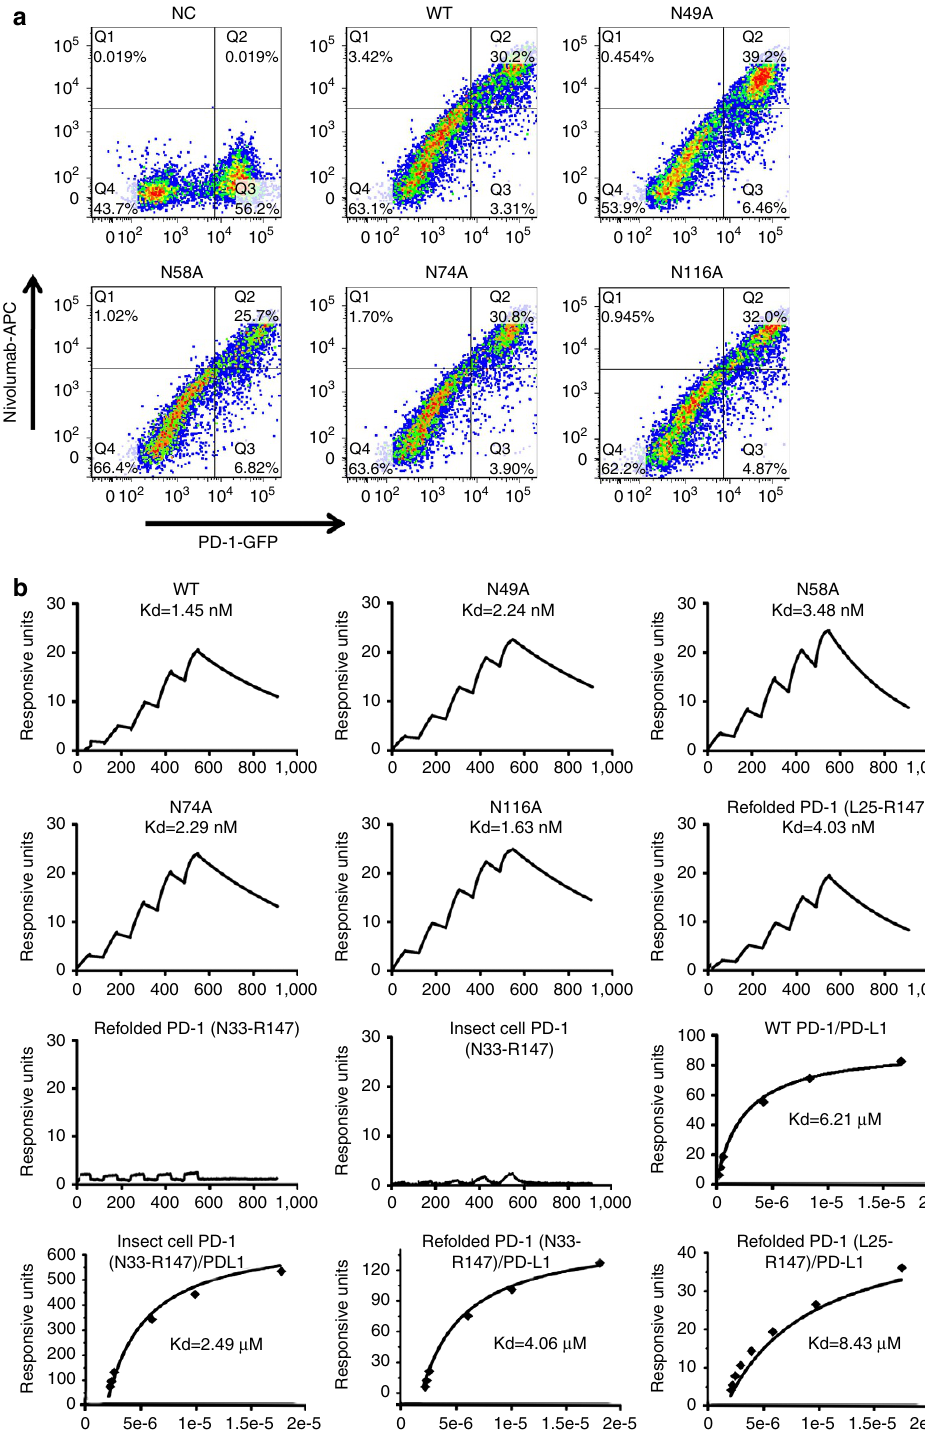
Figure 4 | No evidence for N-glycosylation involvement in nivolumab recognition. ( a ) A flow cytometric assay of nivolumab binding to PD-1 WT or various N-linked glycosylation sites mutated proteins (N49A, N58A, N74A and N116A) expressed on the cell surface of 293T cells. Plasmids expressing the full-length PD-1 WT or mutant proteins fused with EGFP at the C terminus were used for transfection. Mock-transfected 293T cells were used as negative control (NC). ( b ) SPR assay characterisation of the binding between nivolumab and various PD-1 mutant proteins using a BIAcoreT100 system. The PD-1 N-linked glycosylation sites mutant proteins expressed in 293Tcells were used for the assay. The N-linked glycosylation sites mutations in PD-1 showed no effect to the nivolumab binding. The refolded PD-1 proteins with (L25-R147) or without N-loop (N33-R147) expressed in E. coli and PD-1 protein without N-loop (N33-R147) from insect cells were then analysed for binding affinity with nivolumab. The roles of PD-1 N-loop to the binding of PD-L1 were analysed with response units plotted against protein concentrations. No substantial differences was detected among WT PD-1 expressed in 293T cells, refolded PD-1 (L25-R147) expressed in E. coli , and N-loop truncated PD-1 (N33-R147) expressed in insect cells or E. coli . The data presented here are a representative of three independent experiments with similar